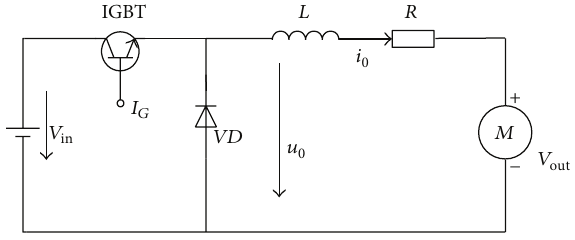
Figure 7: BUCK chopper circuit